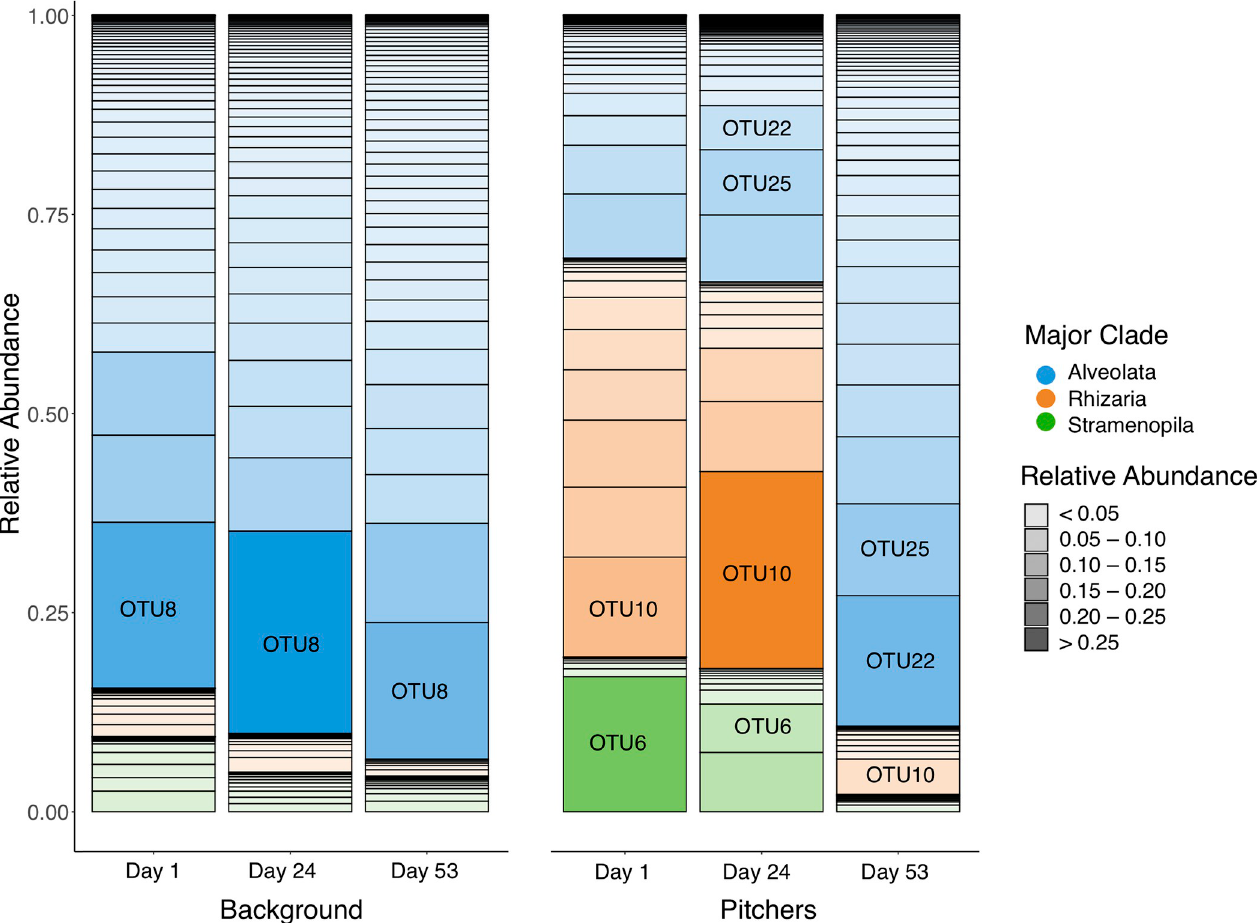
Fig 5. The changes in relative abundance of the OTUs from each sampling month separated by sampling type (background bog water (left) vs pitchers (right); OTUs from discussion labeled) shows that the relative abundance of OTUs assigned to Rhizaria declines sharply over the growing season in pitchers, though much less drastically in the background samples. At the same time, the relative abundance of alveolates increases. Stacked barplots represent relative abundance (denoted by bar segment size and